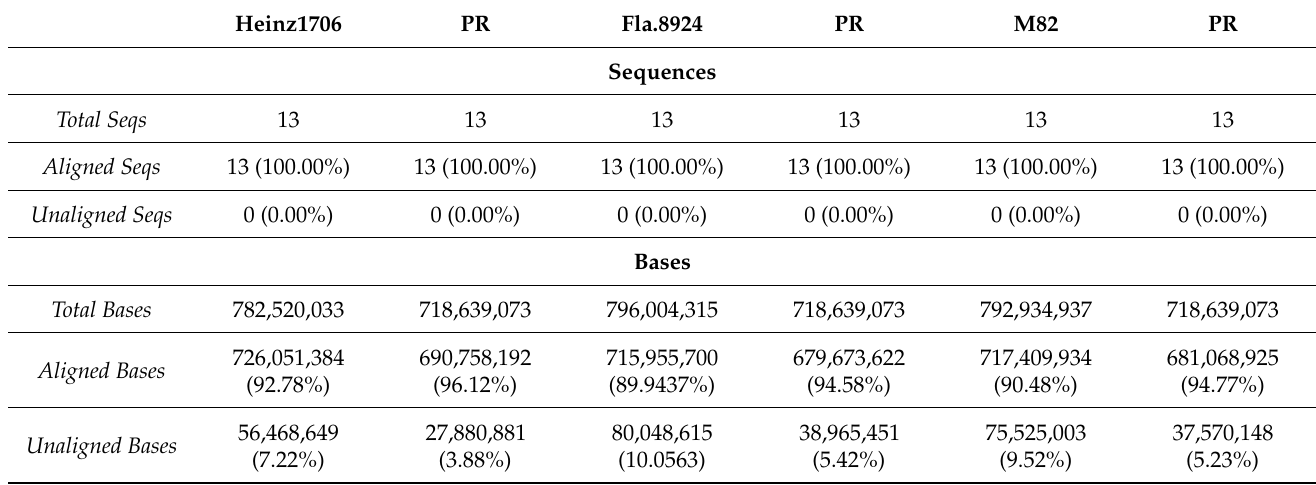
Table 3. Pairwise whole genome comparison of Pusa Ruby against Heinz1706, Fla1, and M82 computed by DNAdiff tool [50]. Pusa Ruby was the query while Heinz1706, Fla.8924, and M82 were the references in the NUCmer alignment and DNAdiff tool. Seqs: Sequences; Avg: